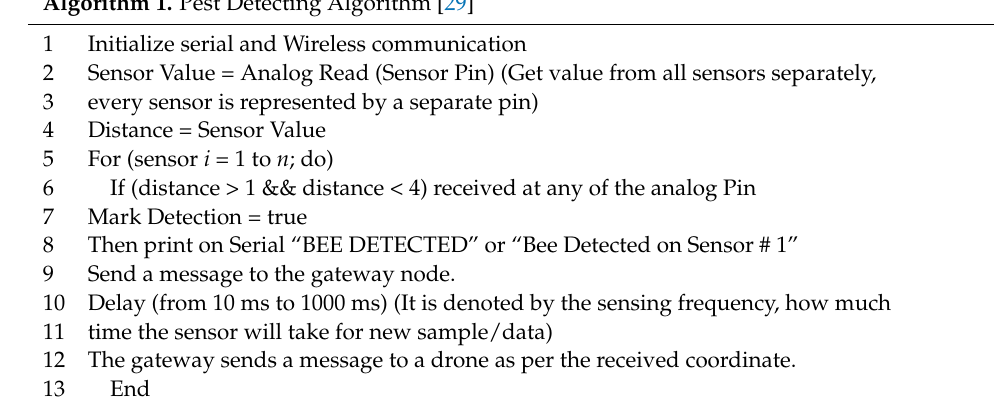
Algorithm 1. Pest Detecting Algorithm